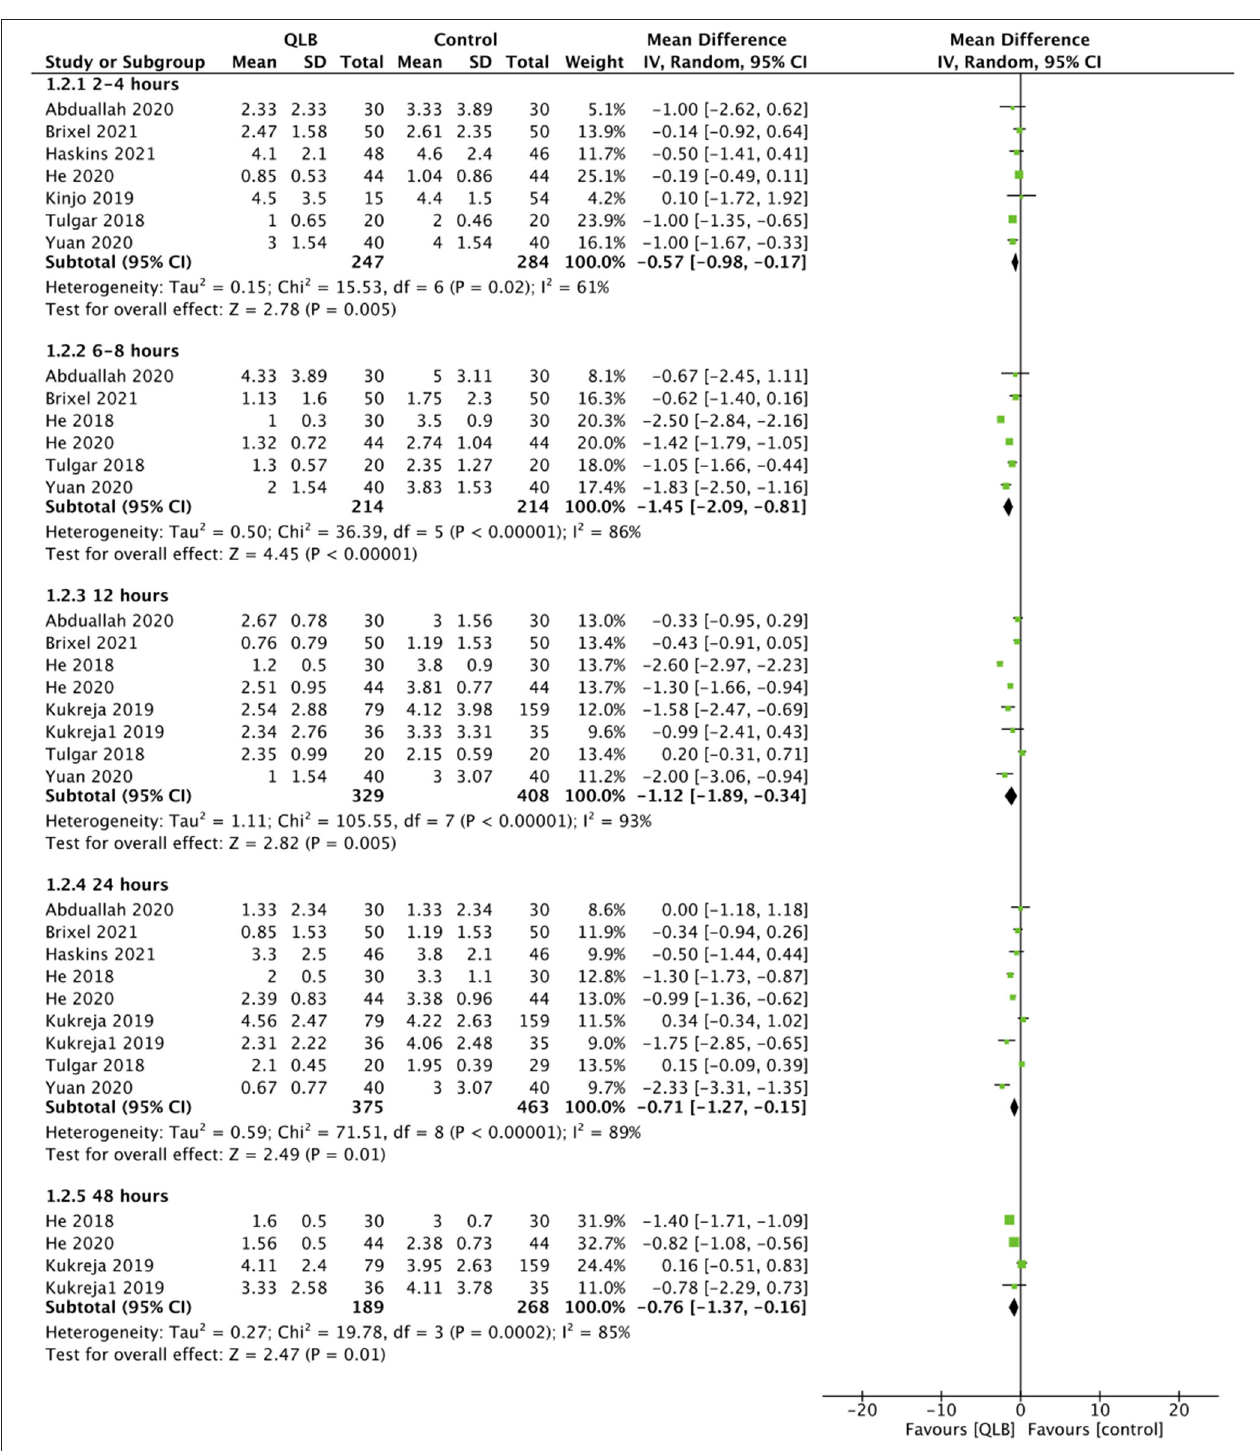
FIGURE 5 | Meta-analysis of pain scores between QLB and control groups with sub-group at different time points.